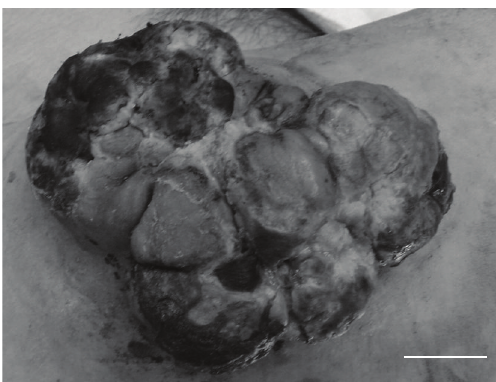
Figure 1: Macroscopic findings of the tumor in the pre-treatment condition. The tumor involved multiple ulcers and necrotic tissues. Bar =